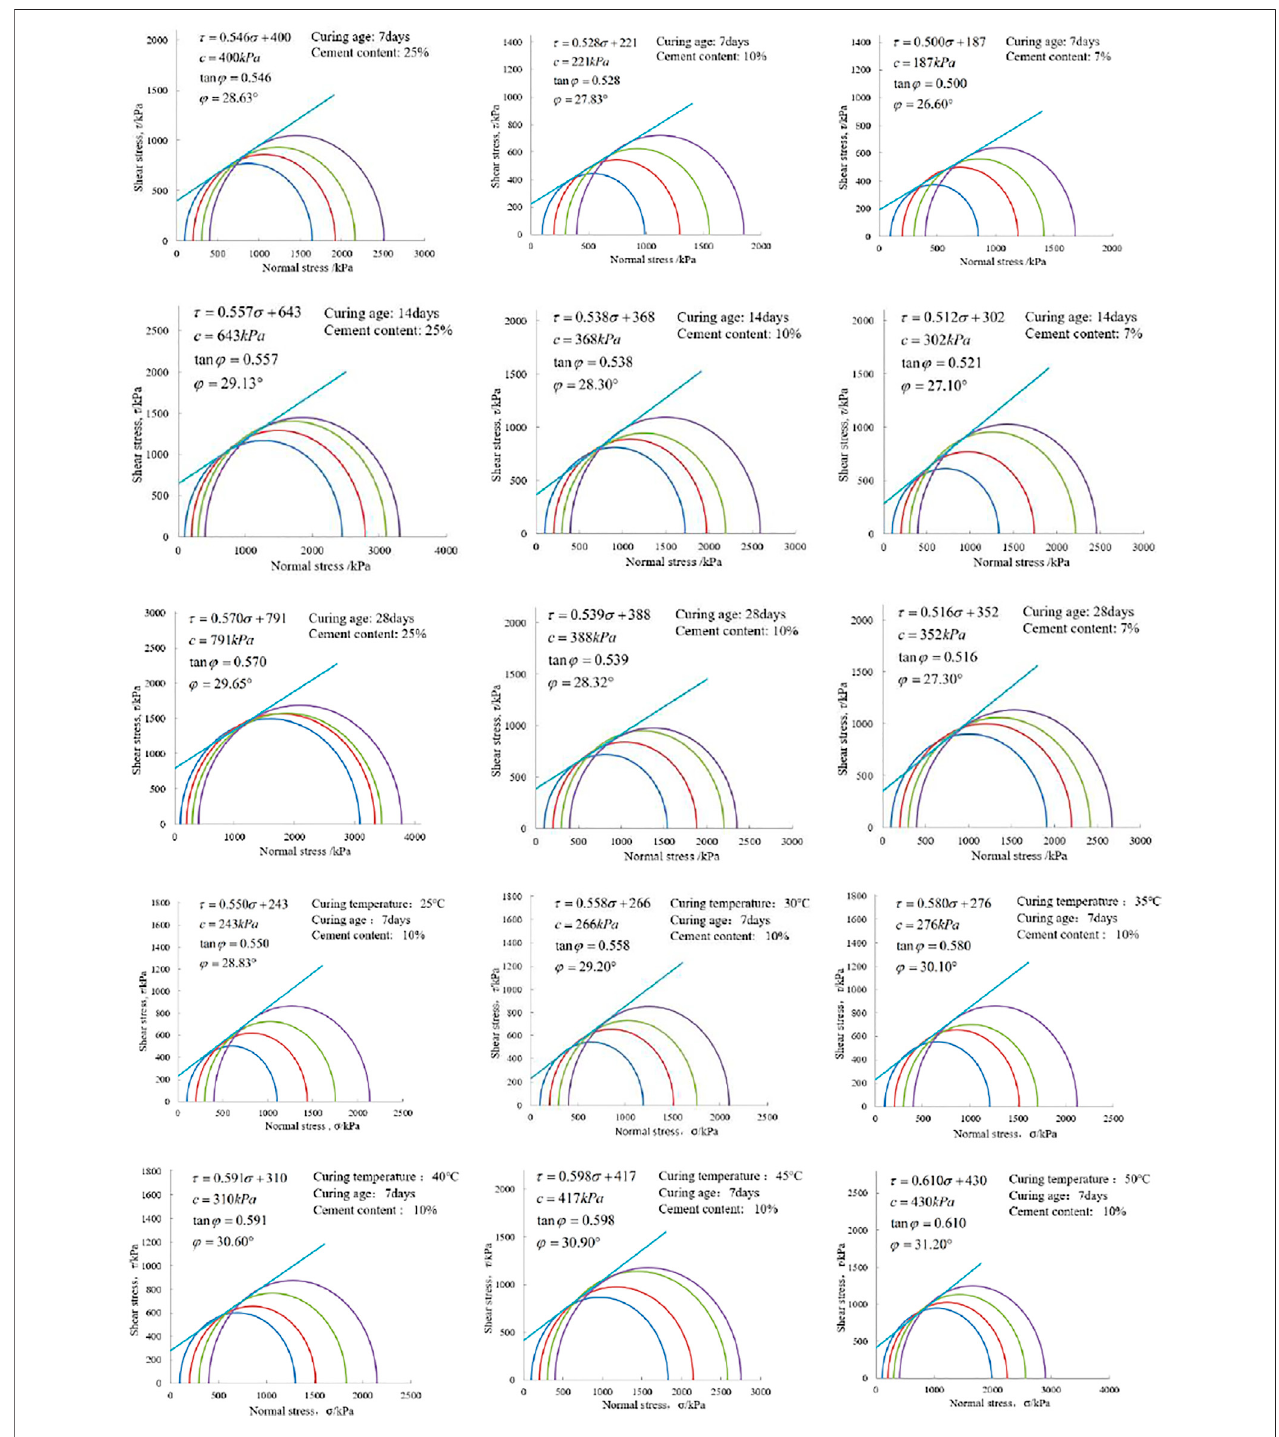
FIGURE 3 | Triaxial compression test results of CPB